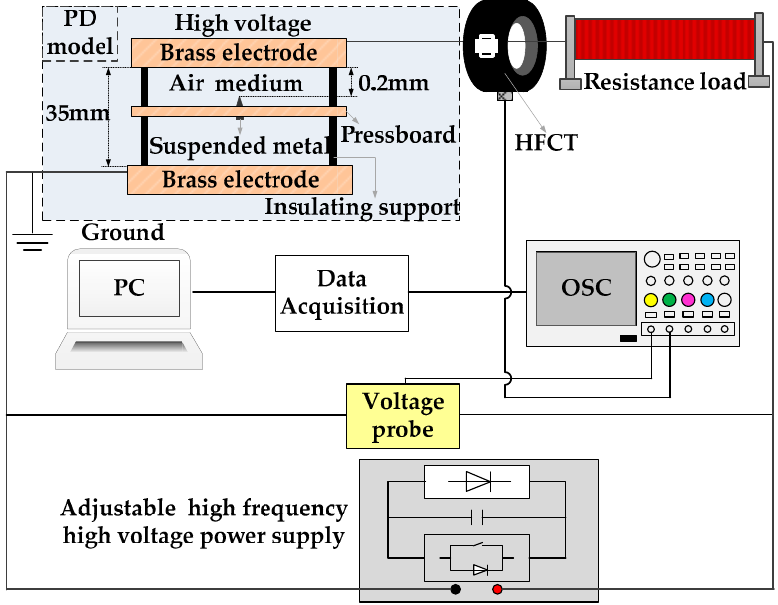
Figure 2. Partial discharge test platform for a high ‐ frequency transformer.